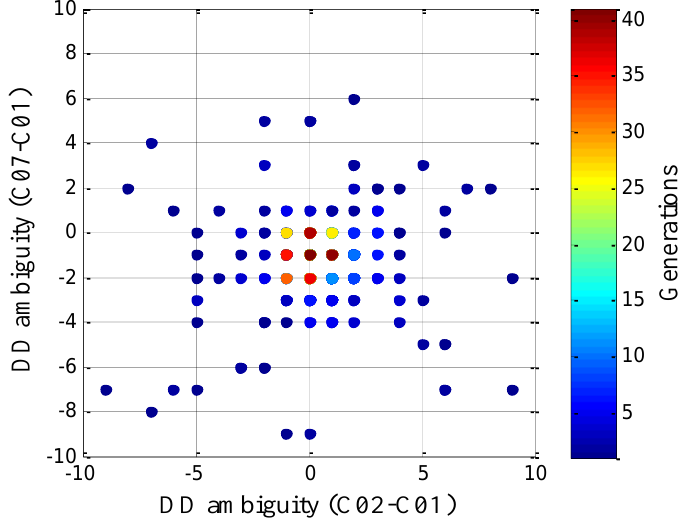
Figure 4. Example of IPSO–AR search procedure. DD: double differenced.